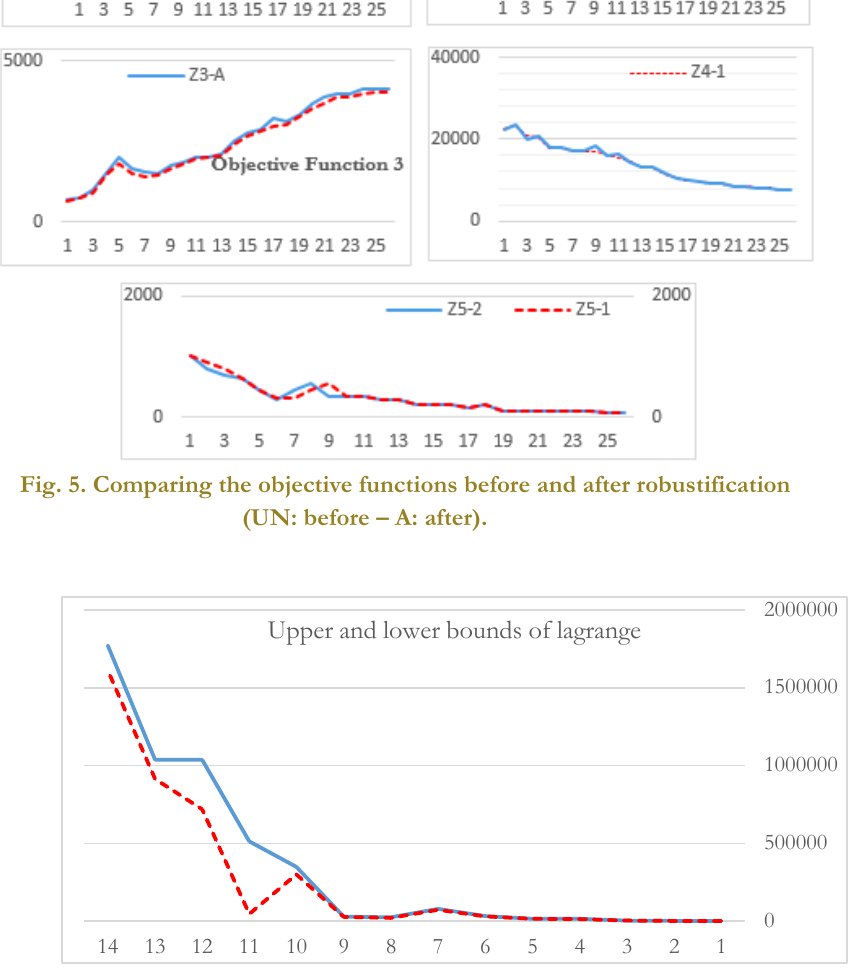
Fig. 6. Convergence of upper and lower bounds of the Lagrange algorithm after relaxing a hard constraint.